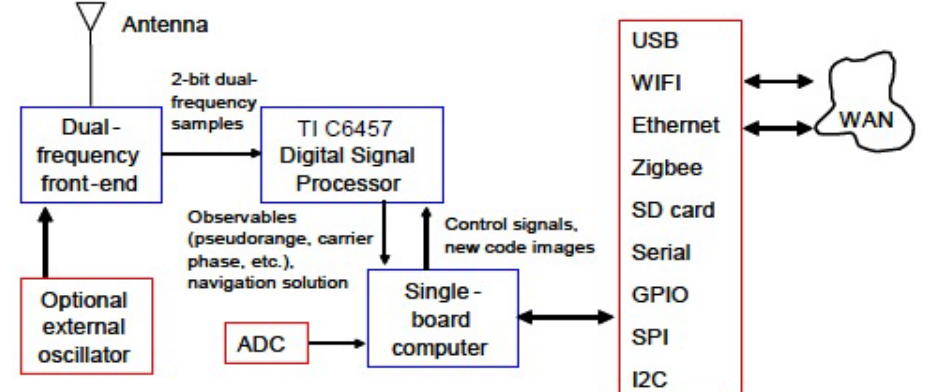
Figure 1. Block diagram of the CASES receiver hardware.